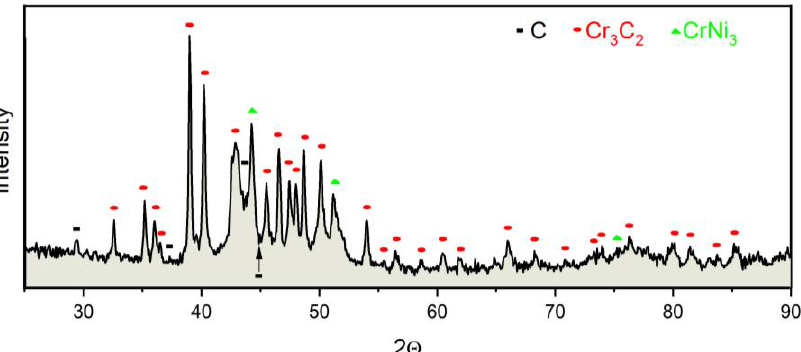
Figure 5. The phase composition of manufactured coating Cr 3 C 2 –NiCr deposited on AZ31 magnesium alloy.